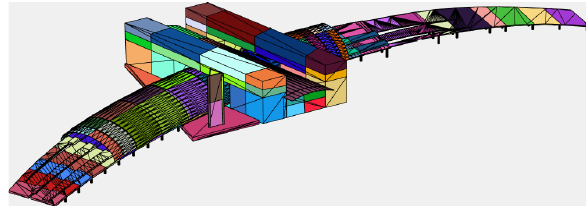
Figure 9. Manually segmented mesh of the Berlin Central Station - each color indicates an individual segment